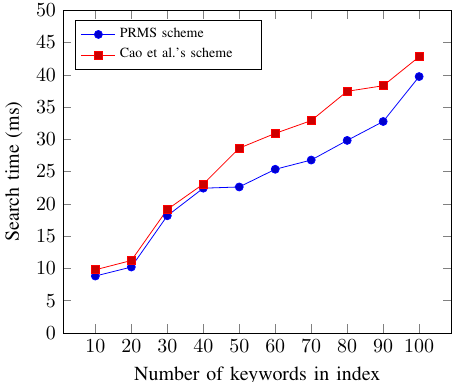
Figure 9. Time cost on the search process over 200